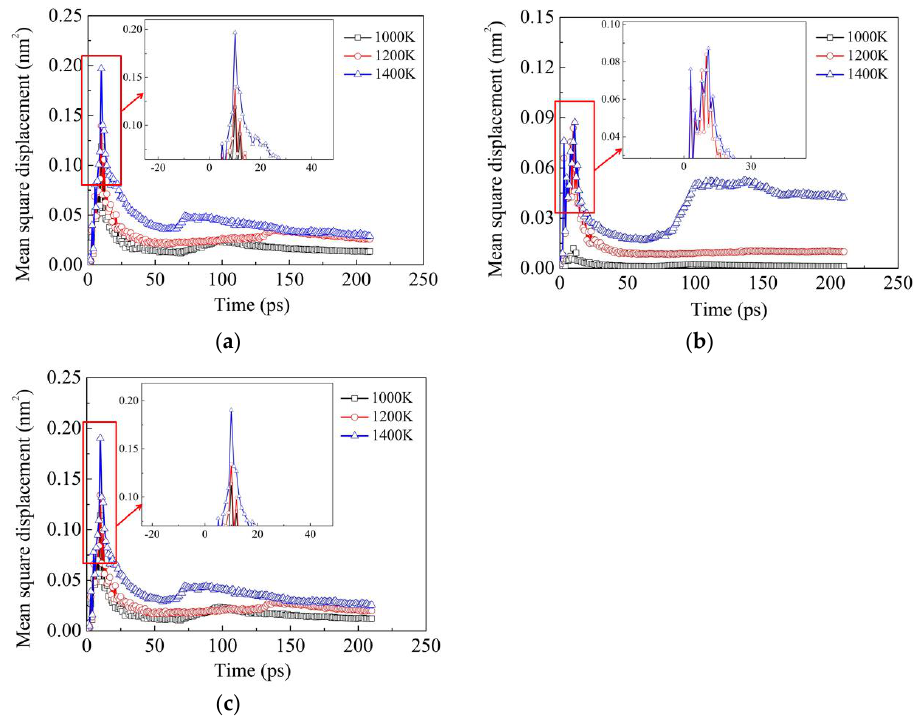
Figure 7. Influence of temperature on the MSD results of Fe, Ni and Cr elements in Model Ι subjected to the vertical pressure of 50 MPa: ( a ) Fe; ( b ) Ni; ( c ) Cr.